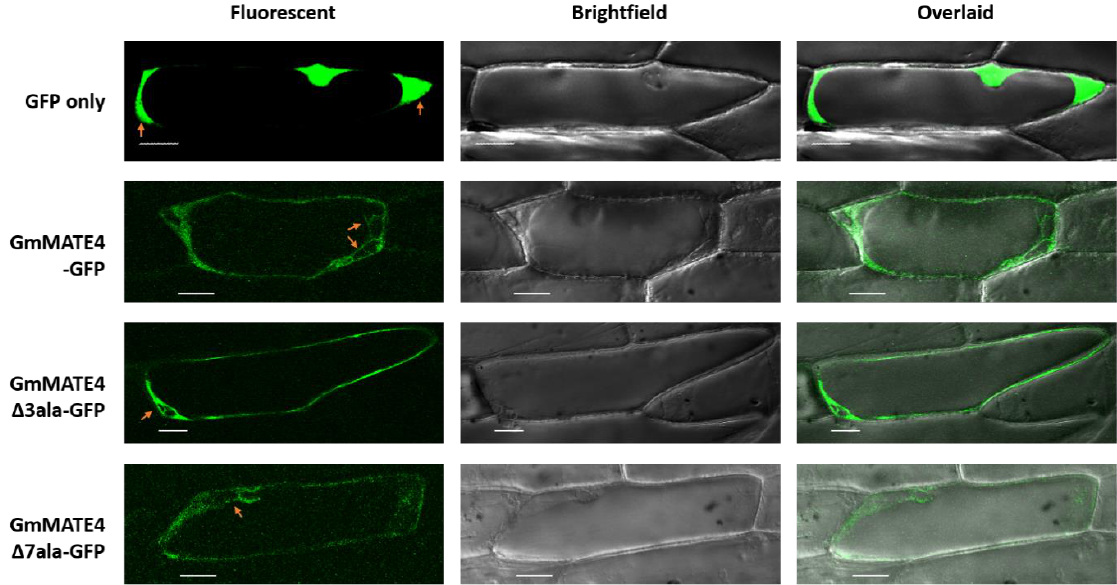
Figure 3. Subcellular localization study of GmMATE4, GmMATE4Δ3ala, and GmMATE4Δ7ala. GFP was fused to the C- termini of GmMATE4, GmMATE4Δ3ala, and GmMATE4Δ7ala. The fusion construct was cloned downstream of a CaMV 35S promoter in the plasmid V7. The plasmid was coated onto gold particles, bombarded into onion epidermal cells, and then, observed using a confocal microscope. Scale bar, 50 μm ; excitation 488 nm; and the emission signal was collected between 500 and 545 nm. All cells having the green, fluorescent signal ( ≥ 11 cells) from two biological repeats showed the same